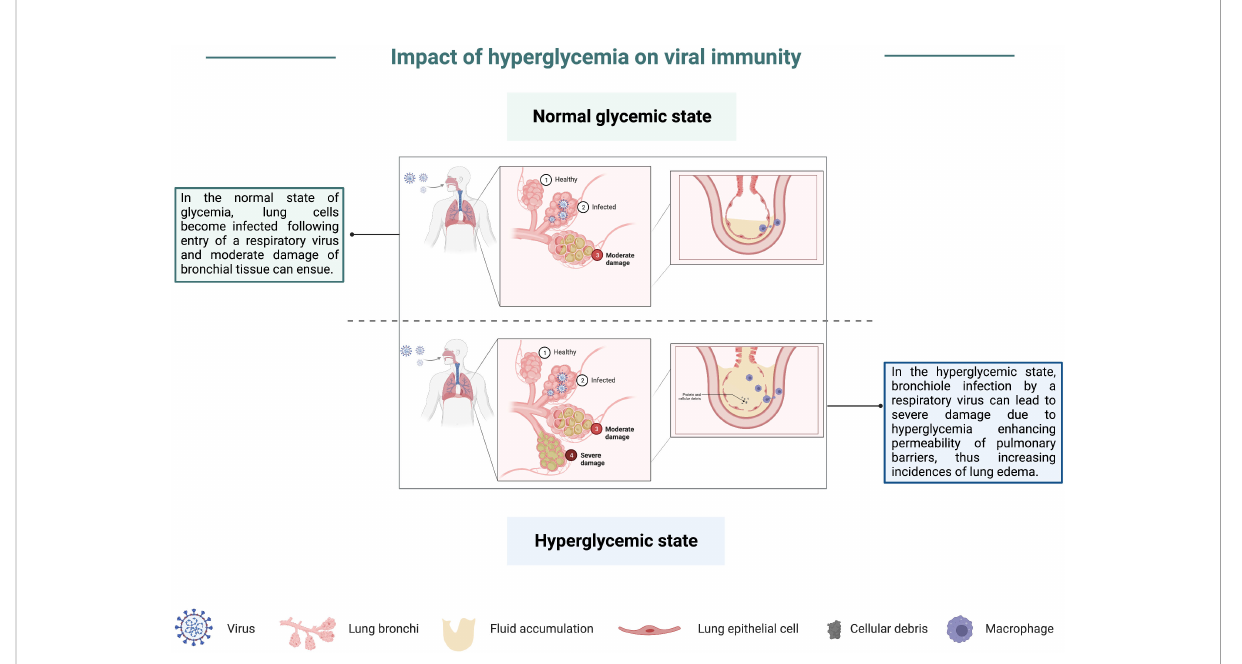
FIGURE 6 Impact of hyperglycemia on viral immunity. In a state of normal glycemia levels, lung cells can become infected by a respiratory virus, which may result in moderate damage to bronchial tissue. However, in the hyperglycemic state, severe damage of bronchioles following viral pathogen infection is more likely due to an impairment in lung barriers, thus enhancing their permeability and increasing the incidence of lung